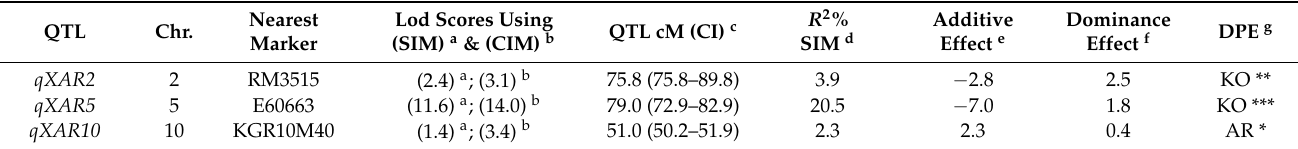
Table 2. QTLs controlling lesion length after inoculation of Xoo race II.